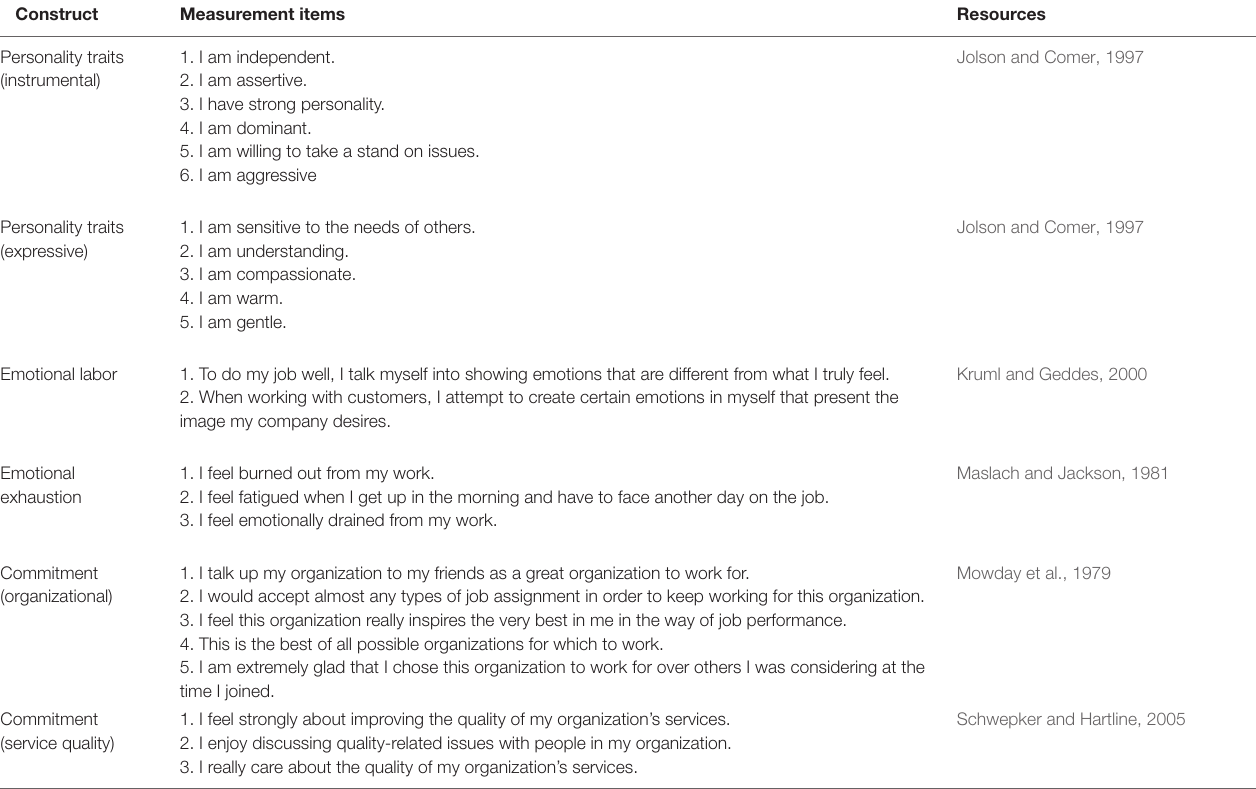
TABLE 2 | Resources and measurements of